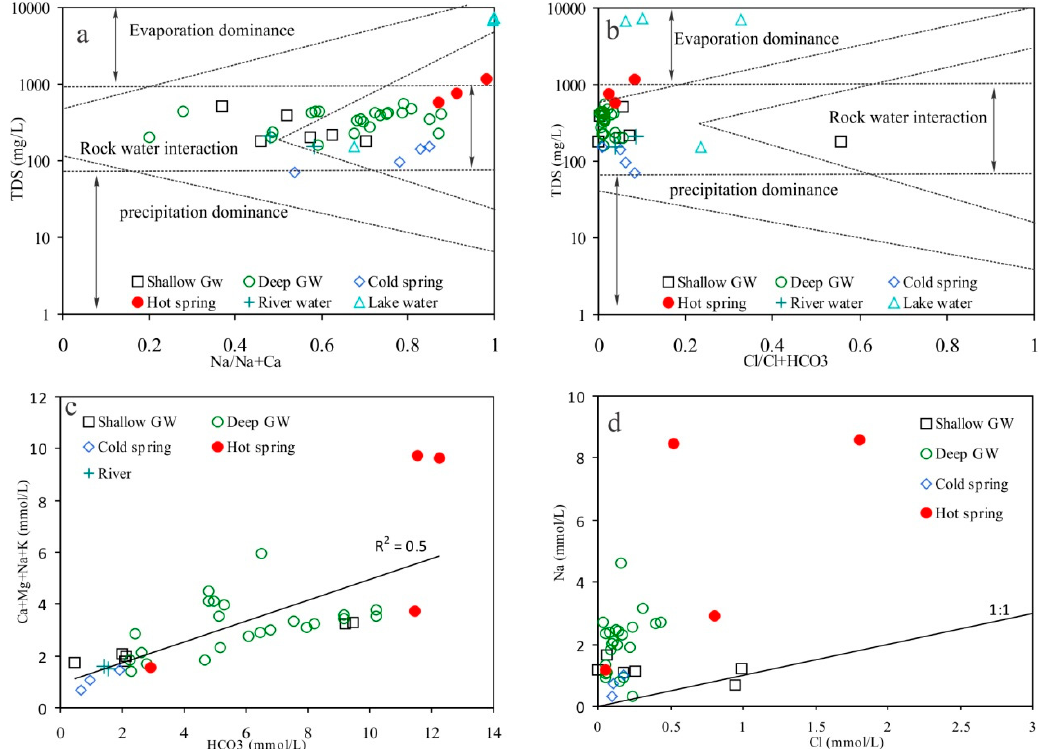
Figure 6. Plot of TDS versus the weight ratios of Na + /(Na + + Ca 2+ ) ( a ), the weight ratios of Cl − /(Cl − + HCO 3 − ) ( b ) Gibbs [56], Relationship between major cations species and (HCO 3 − ) ( c ), plot of Na + versus Cl − ( d ).